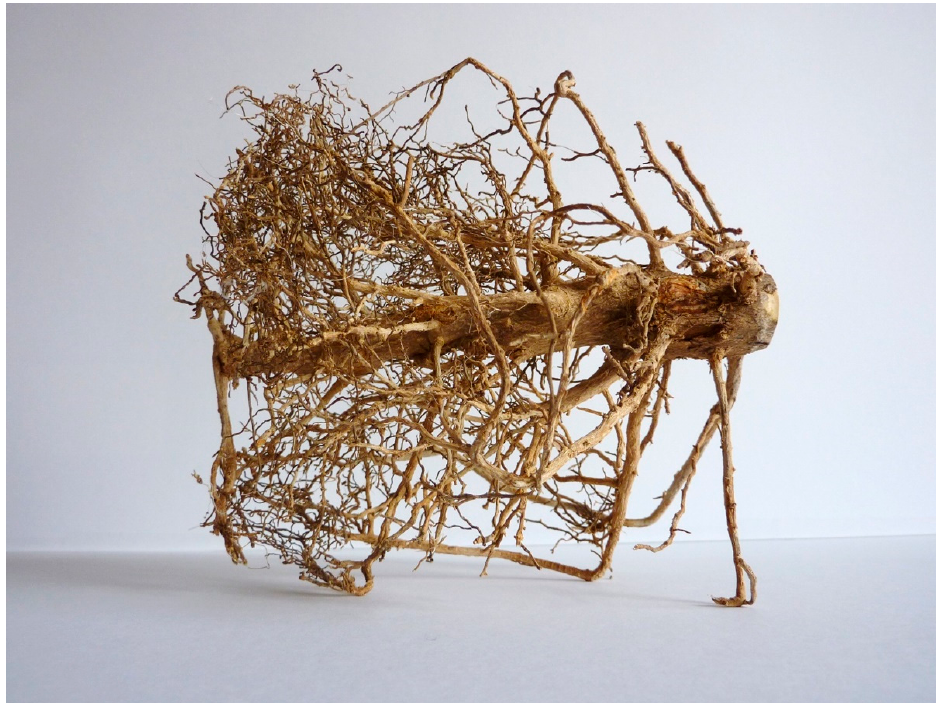
Figure 4. John Newling (b. 1952) The Lemon Tree and Me (2010). (Courtesy of the